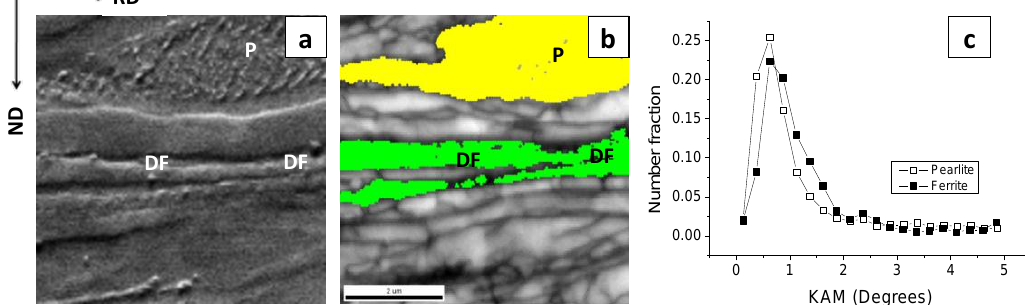
Figure 5. ( a ) SEM image; ( b ) IQ map and ( c ) KAM versus number fraction for 70% cold-rolled material. Letters in arrows are P for pearlite; and DF for deformed ferrite. Step size 50 nm.